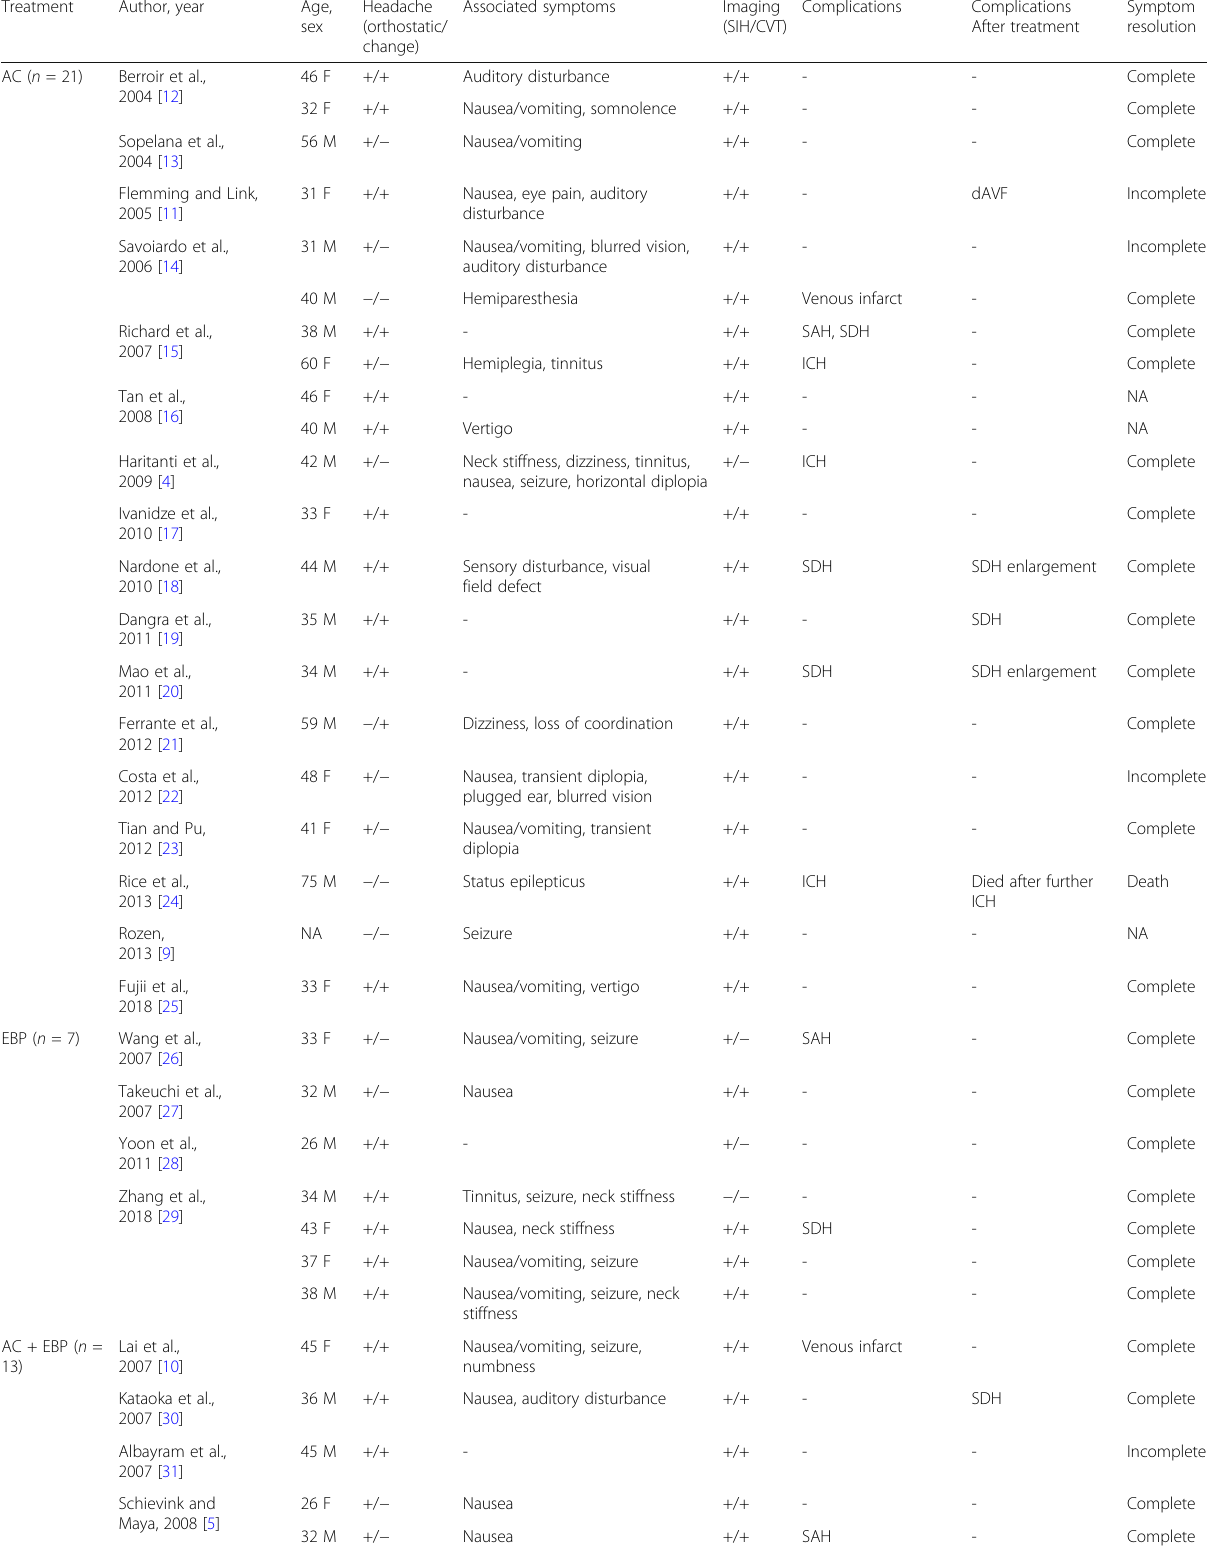
Table 1 Clinical and radiologic data for 42 patients with CVT